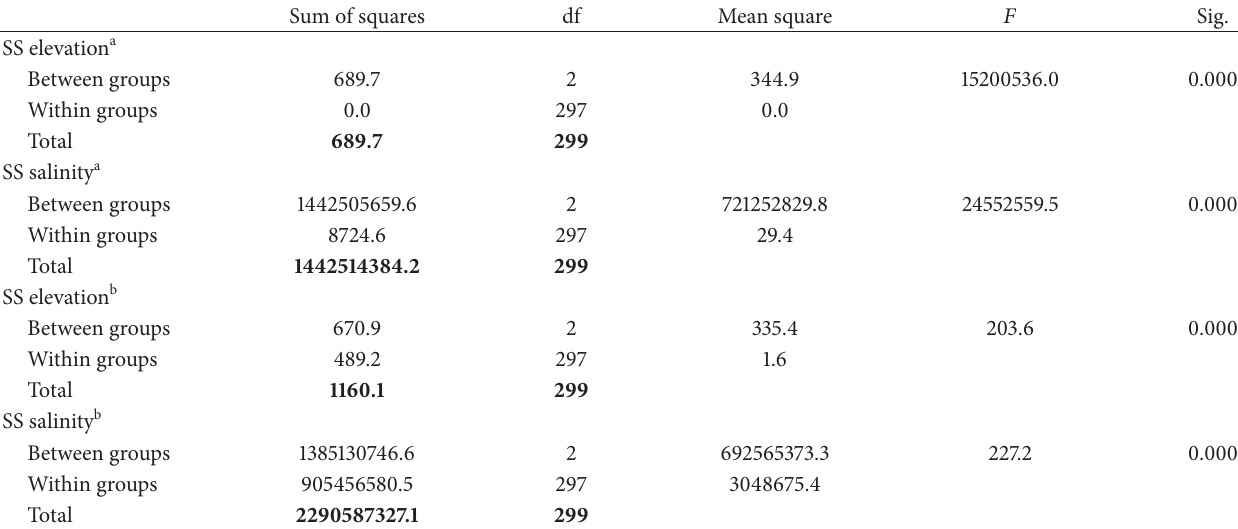
Table 5: Salton Sea (SS) climate sensitivity analysis: one-way ANOVA results. Sum of squares df Mean square 𝐹